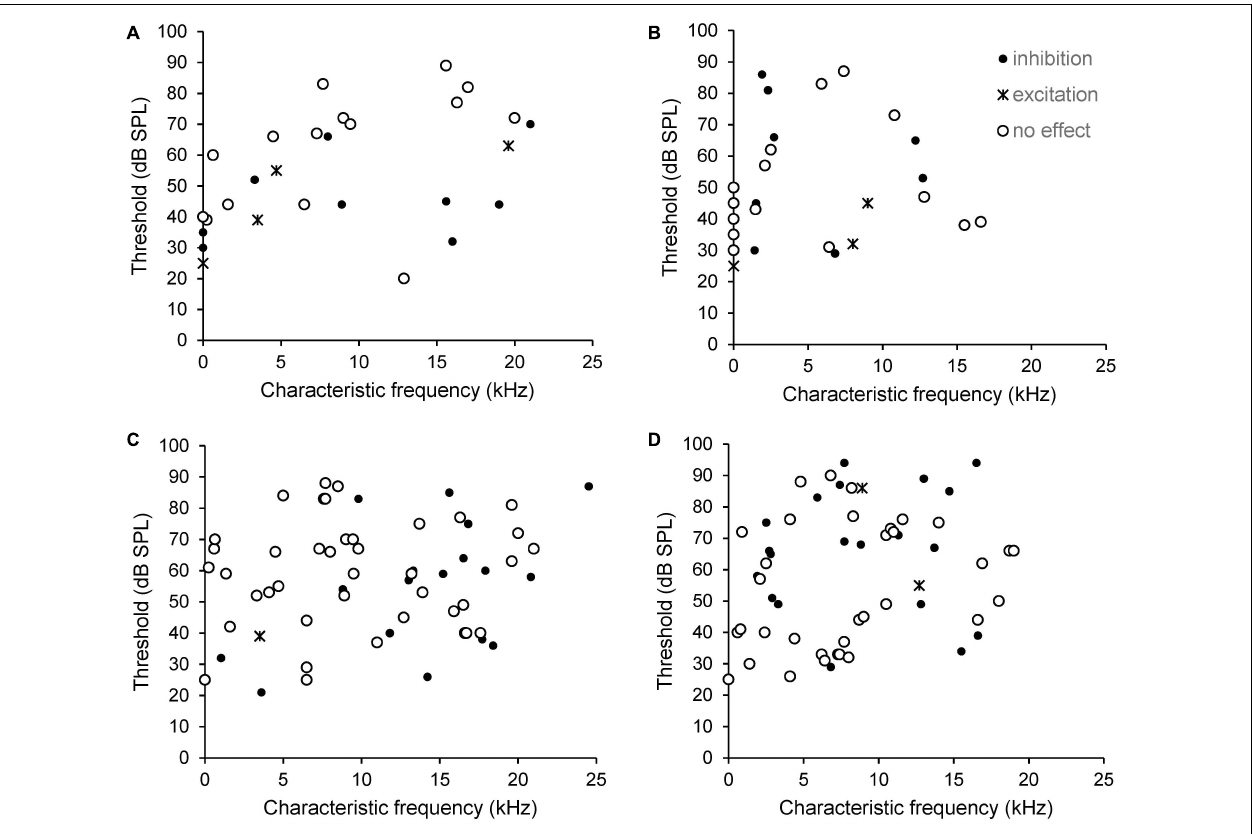
FIGURE 4 | Scatterplots showing the relationship between CF, threshold and type of effect from electrical stimulation of the PFC on SFR ( A , sham and B , AT) and on sound evoked responses at CF 20 dB above threshold ( C , sham and D , AT). Neurons that could not be tuned to a pure tone are shown arbitrarily with a CF of zero and an arbitrary threshold, so appear on the Y -axis. Black dots: neurons showing inhibition. Crosses: neurons showing excitation. Open circles: neurons showing no